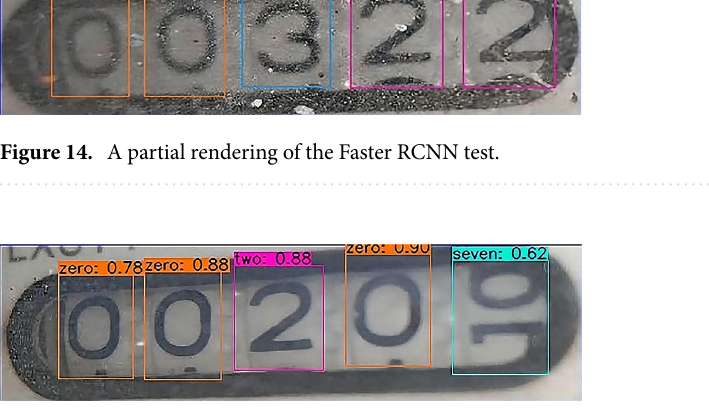
Figure 15. Partial renderings of SSD tests.